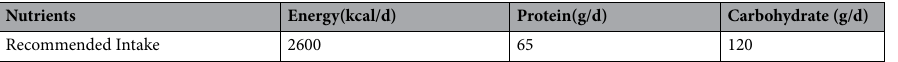
Table 3. Recommended intake for an adult man of the three nutrients.